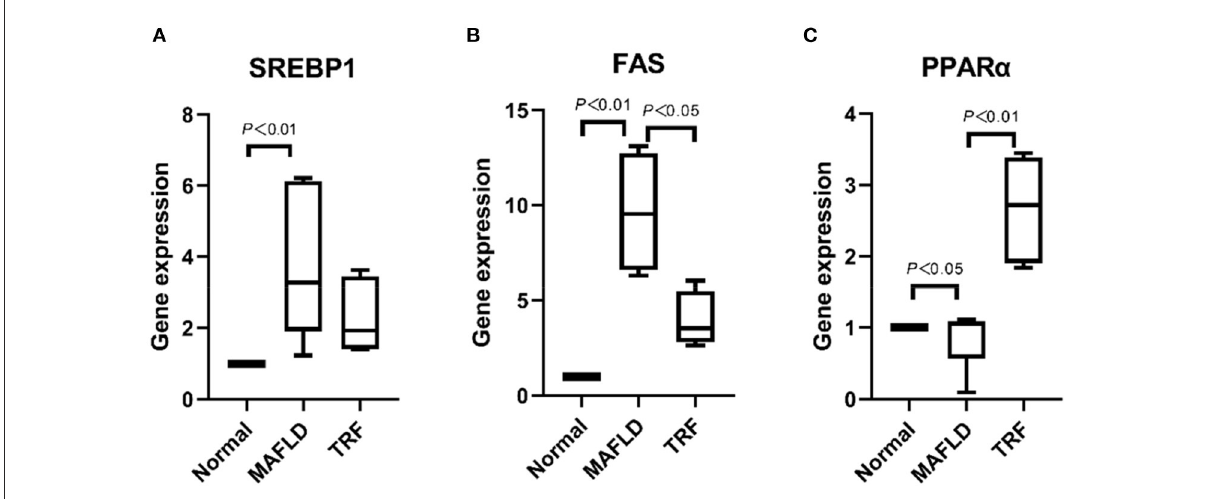
FIGURE10 The mRNA levels associated with lipid metabolism in liver. (A) SREBP1, (B) FAS, and (C) PPAR α . The data are presented as percentile. Normal, rats fed a normal diet ad libitum ; MAFLD (metabolic associated fatty liver disease), rats fed a high-fat diet ad libitum ; TRF (time-restricted feeding), rats fed high-fat diet (60 kcal% Fat) strictly between 16:00 to 22:00 every day.